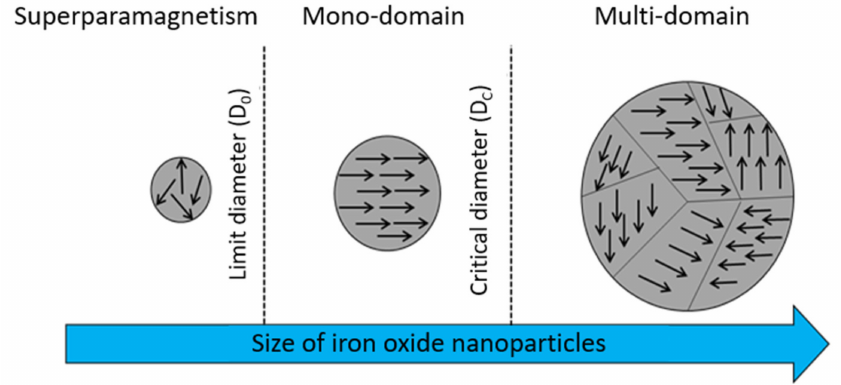
Figure 5. Evolution of the magnetic organization of nanoparticles according to their